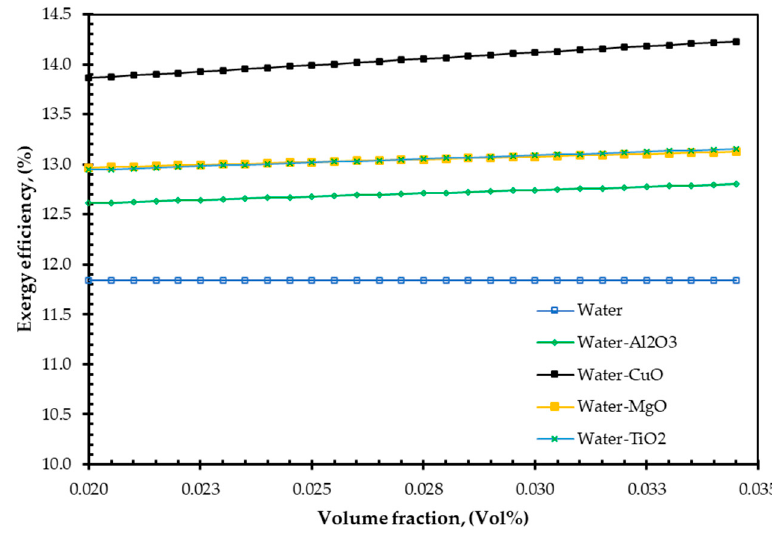
Figure 5. Effect of volume fraction on exergy efficiency.